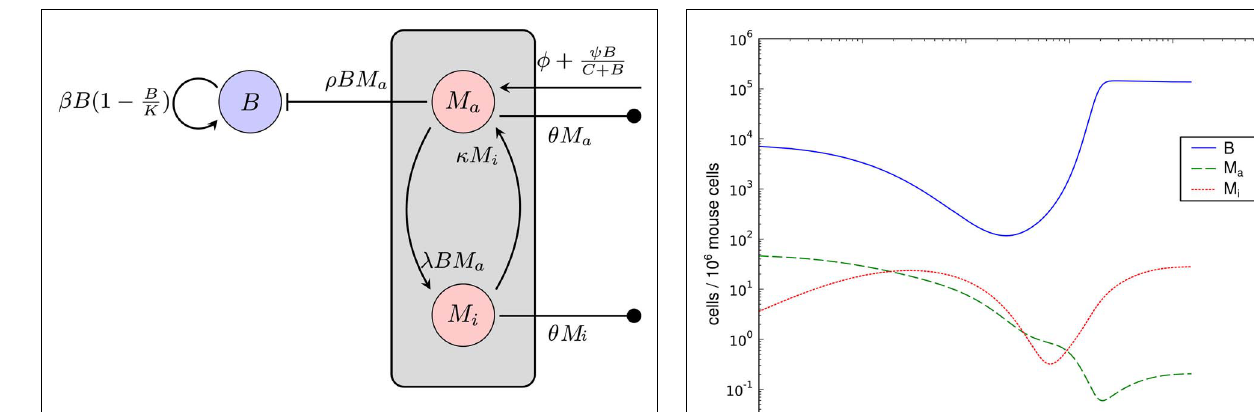
FIGURE 3 | Model of the bacterial dynamics at the infection site with limited phagocytic capacity of the immune cells. The phagocyte population is subdivided into an active M a and an inactive M i compartment. B : bacterial population at the infection site, β : bacterial replication rate, K : carrying capacity, ρ : phagocytosis rate, φ : physiological phagocyte migration into infection site, ψ : phagocyte recruitment as infection response, C : bacterial concentration yielding half-maximal recruitment of phagocytes, θ : phagocyte death rate, λ : inactivation rate of phagocytes, κ : rate of re-activation of phagocytes.